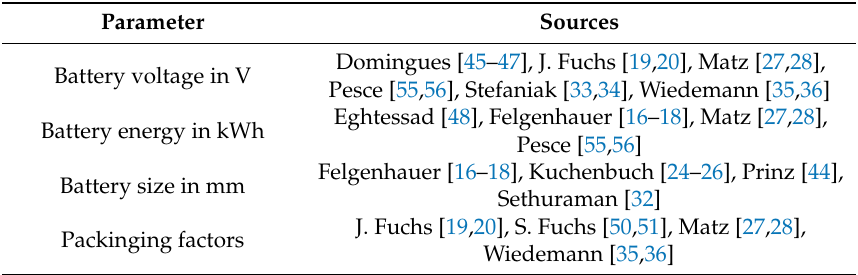
Table 5. Overview of the design parameters for the battery.